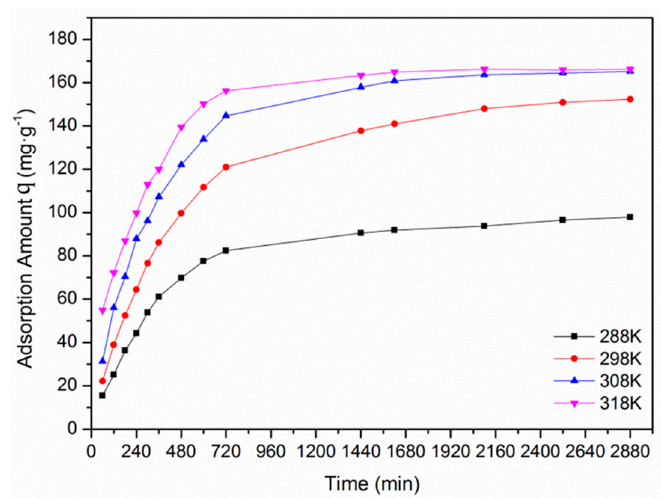
Figure 8. The effect of temperature on the adsorption of EBT by F-SAC.